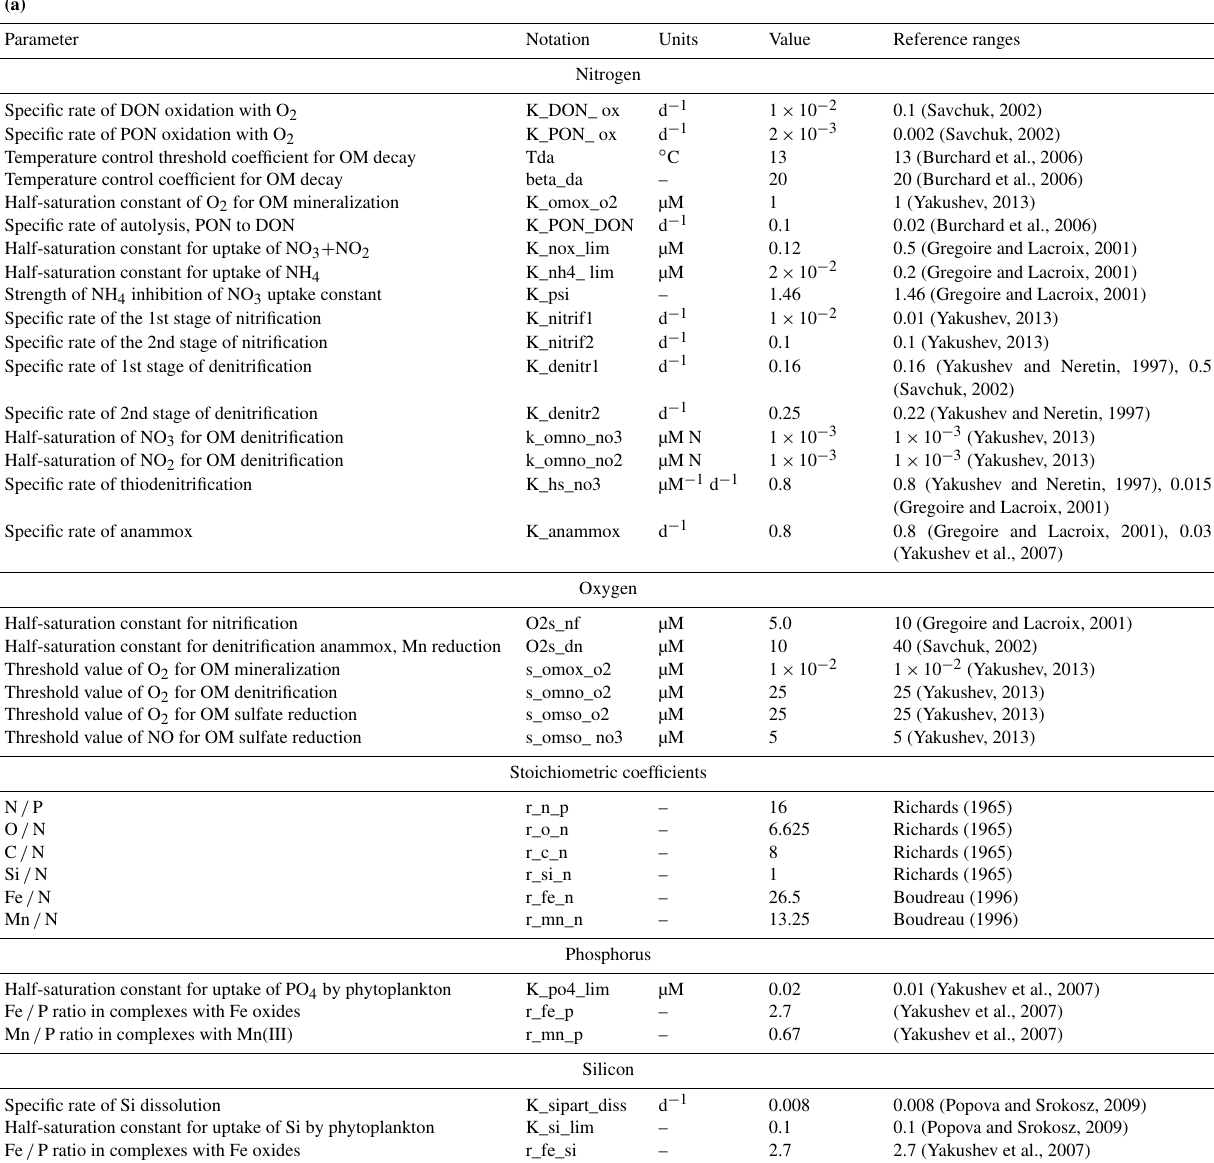
Table 3. Parameter names, notations, values, and units of the coefficients used in the model: (a) nutrients and oxygen; (b) redox metals and sulfur; (c) carbon; (d) ecosystem parameters; (e) sinking.